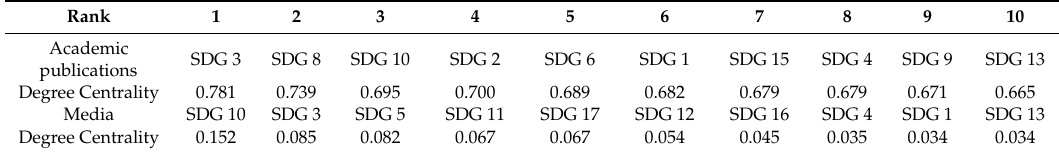
Table 3. The top ten SDGs with highest degree centralities in the network with 136 SDG pairs. To present the essential nodes and linkages more explicitly, we redrew the network graph as Rank Figure 6, in which several SDGs with higher total frequencies were shown as bigger icons and only those linkages with tied frequencies bigger than 125 for academia and 5 for media were shown. Thicker lines indicated higher tied frequencies. General speaking, SDG 3 and SDG 10 had powerful connections with other SDGs in both industries. Besides, SDG 8 and SDG 5 had relatively strong connections with several SDGs for academia and media,